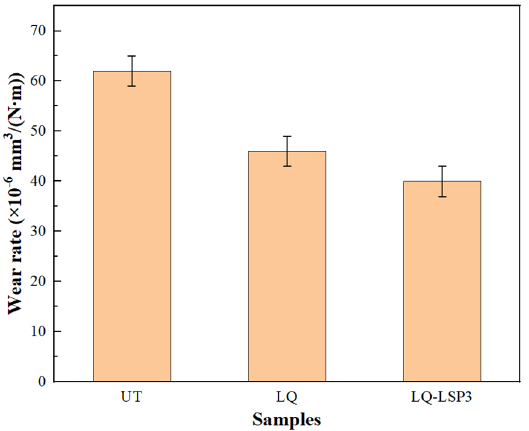
Figure 17. Wear rate of specimens treated with different